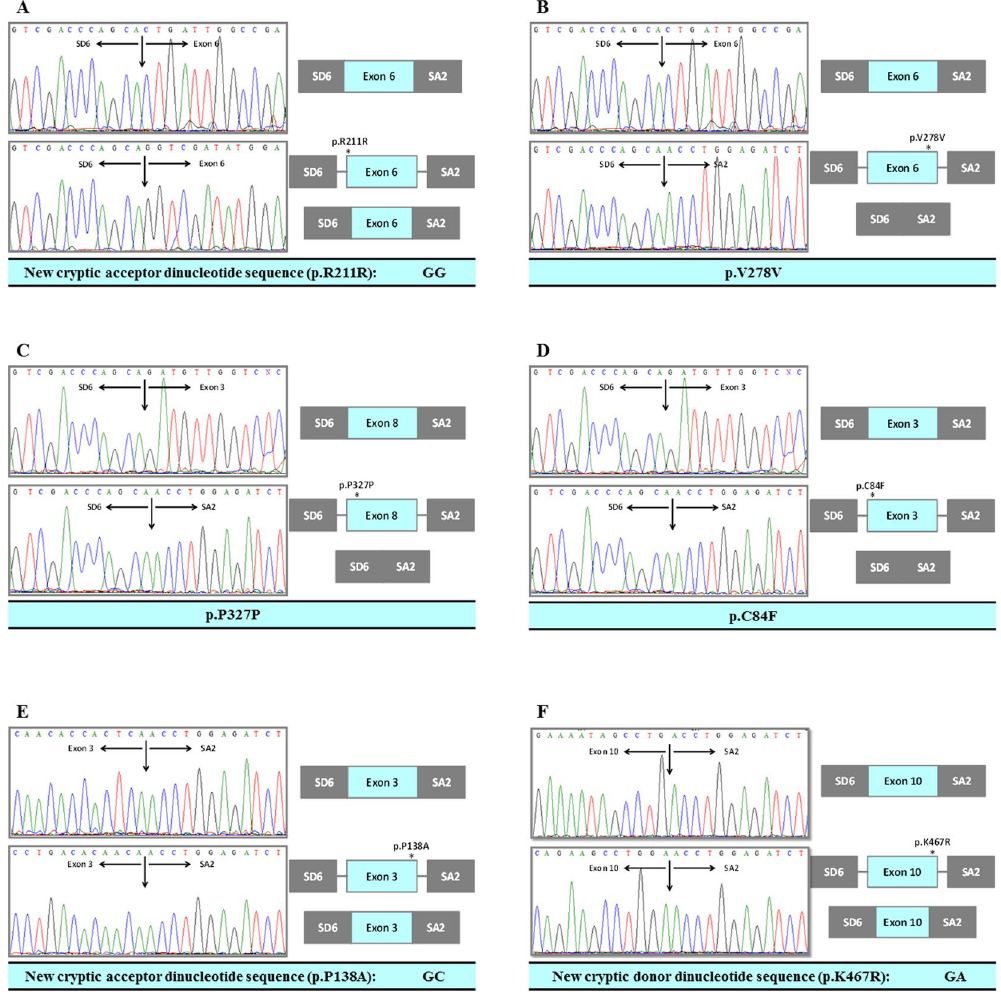
Figure 3. In vitro mRNA processing for synonymous mutations (p.R211R, p.V278V and p.P327P) and missense mutations (p.C84F, p.P138A and p.K467R) that affect the splicing process, identified in the BMPR2 gene. The minigene assay shows the alterations caused by these mutations in mRNA processing. Three of them produces an exon skipping (p.L207_N284del, p.H324_E379del and p.C84Ffs * 12) and three produces partial elimination of an exon (p.P138_S140del, p.E207_G212del and p.K467Rfs *